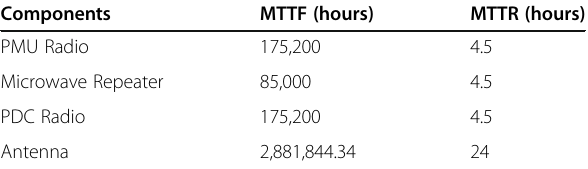
Table 1 The MTTF and MTTR of the constituent components